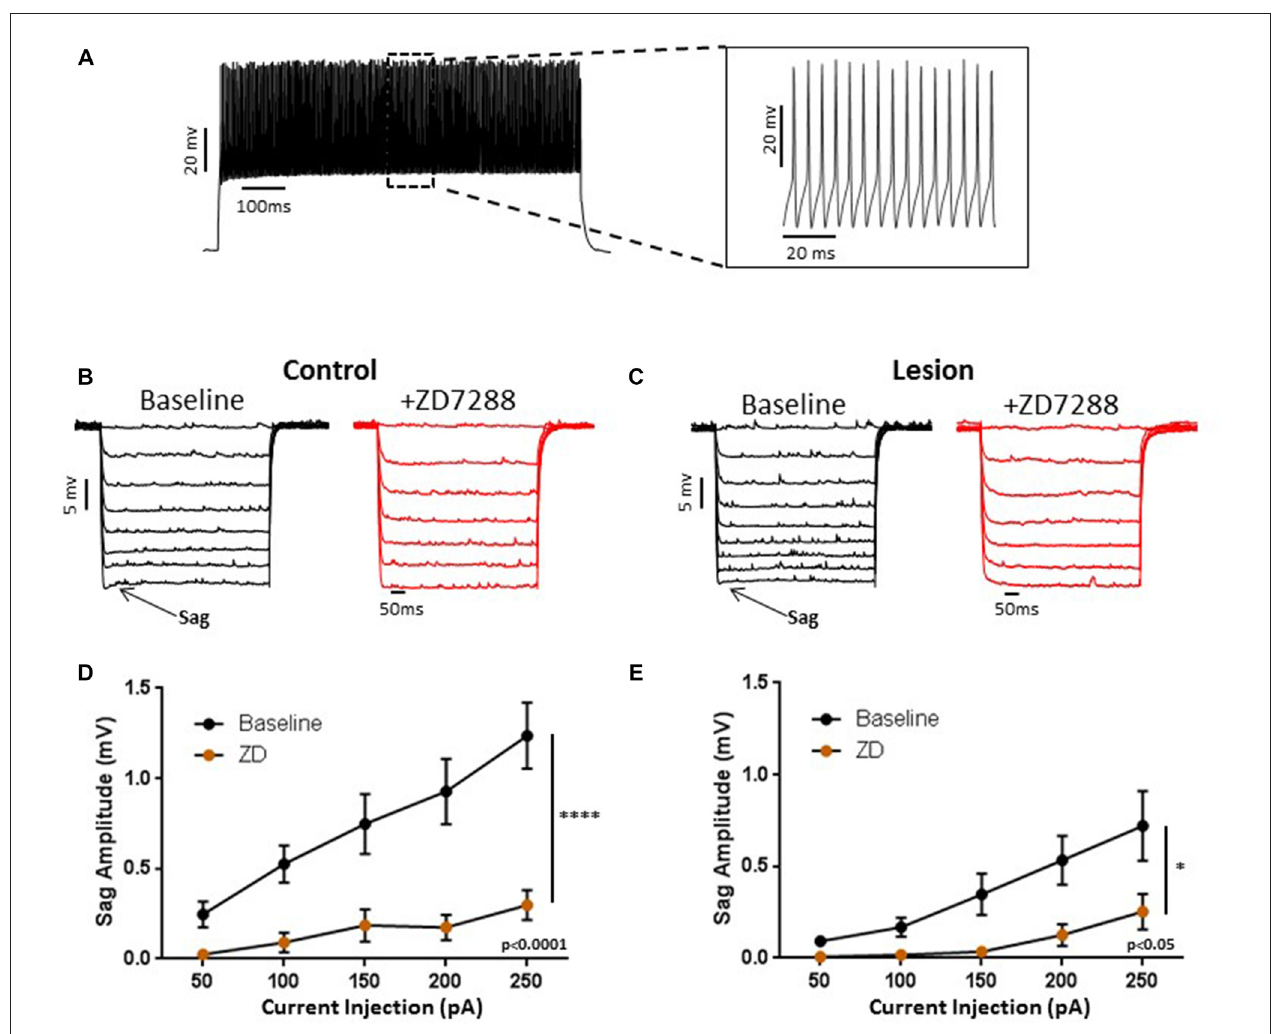
FIGURE 1 | Characterization of hyperpolarization-activated “sag” responses in fast-spiking interneurons in control and lesion groups. (A) Typical spiking response in a fast spiking L5 interneuron from a control animal. Insert shows spikes at higher time resolution. Similar responses were seen in the lesion group. (B) Typical voltage “sag” (arrow) in response to hyperpolarizing current pulses from control animals before (black trace) and after (red trace) administration of ZD7288. (C) Characterization of voltage sag responses as in (B) for fast-spiking interneurons from control animals. Error bars are mean ± SEM. ZD7288 significantly reduced sag response amplitude ( n = 22, 2-way ANOVA, p < 0.0001). (D) Specimen records of responses to hyperpolarizing current pulses in the lesioned group. Typical voltage “sag” (arrow) in response to hyperpolarizing current pulses from lesioned animals before (black trace) and after (red trace) administration